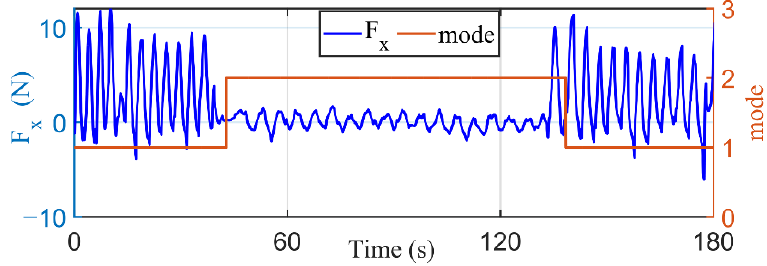
Figure 12. Interaction force and exercise mode.